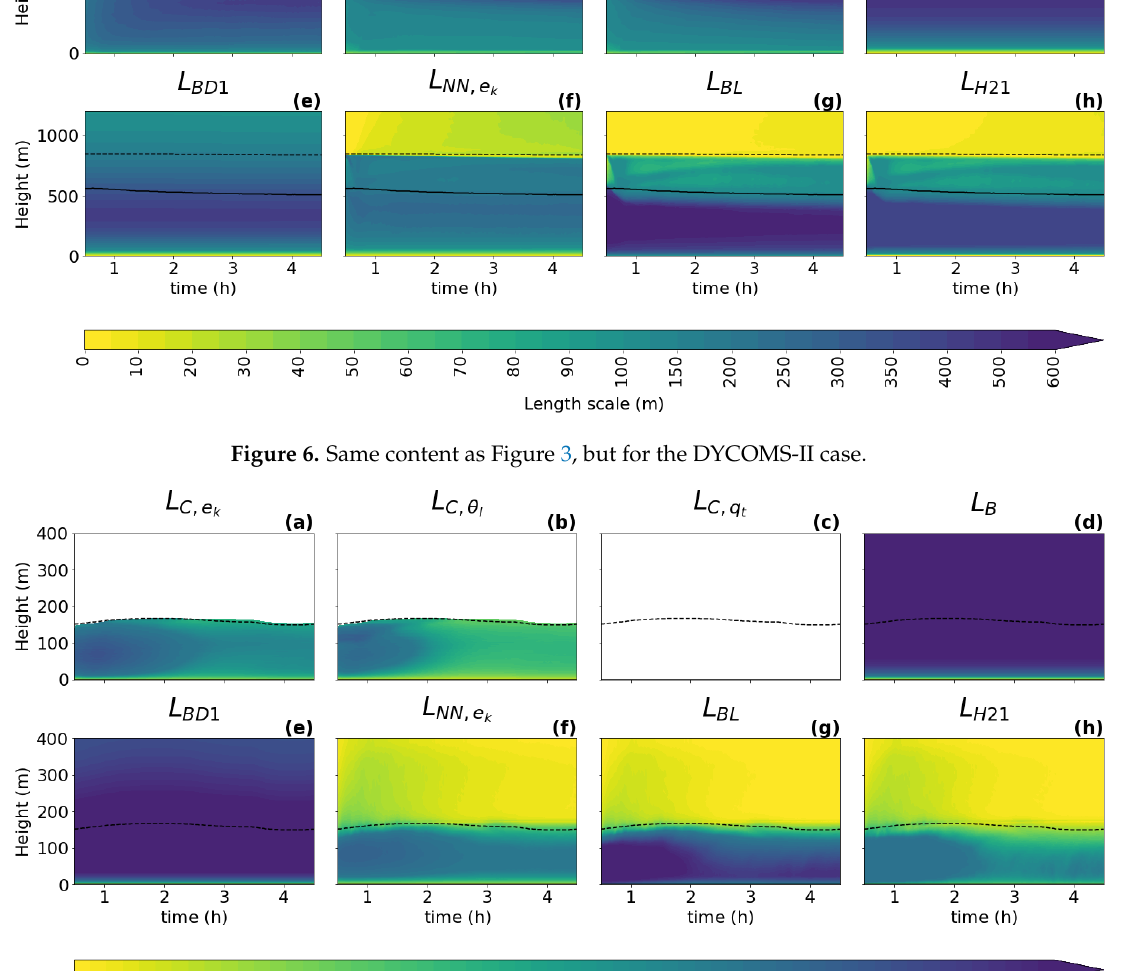
is not plotted for the dry GABLS1 t